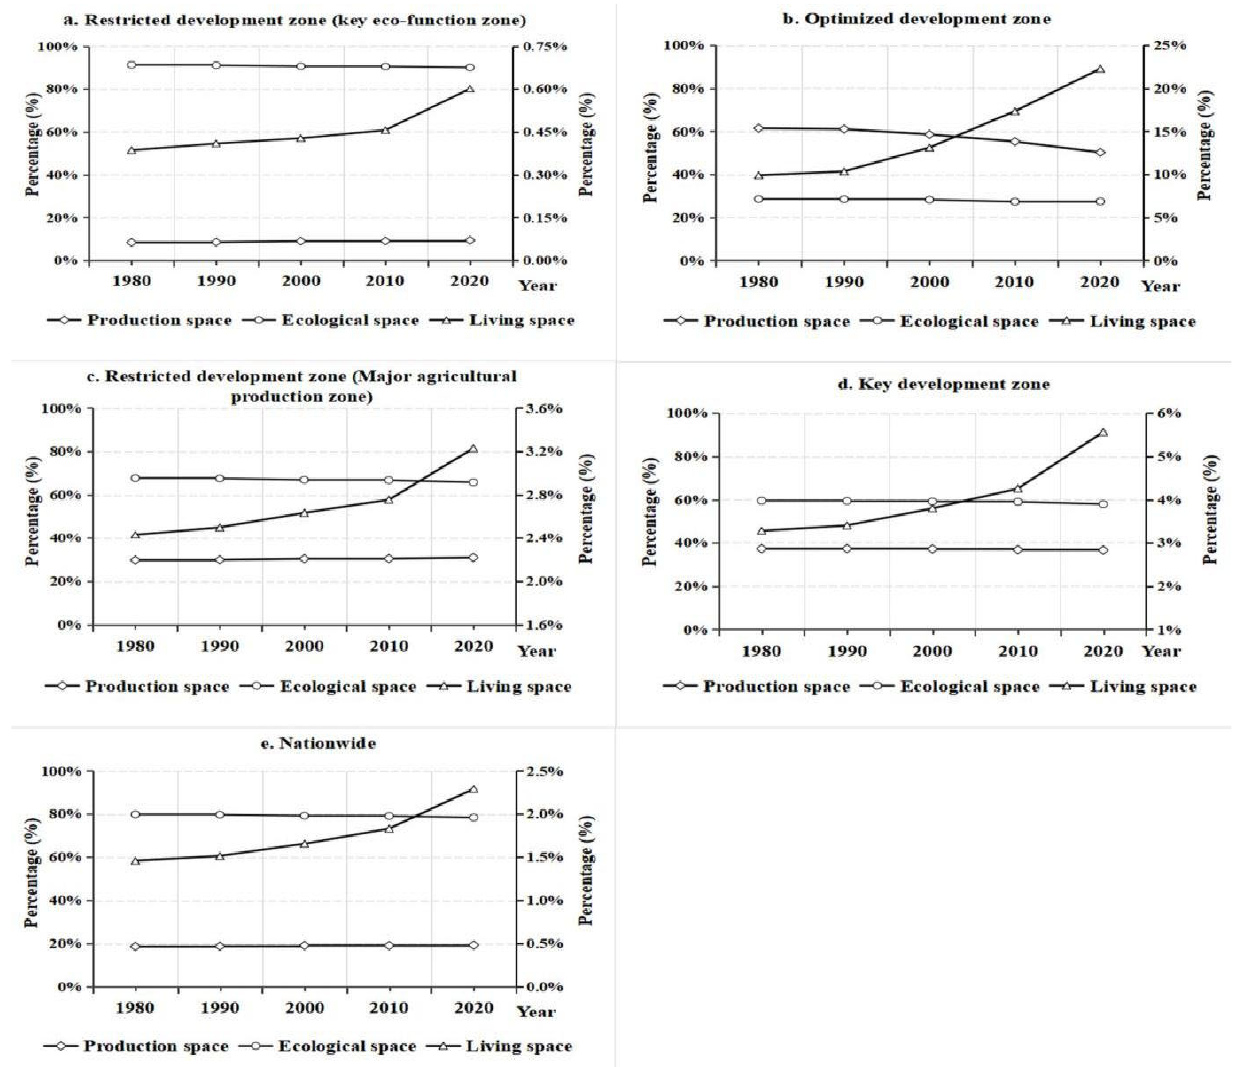
Figure 2. Proportion of PLES in major functional zones in China (%). Note: Production space and ecological space correspond to the main axis ( left ); living space corresponds to the sub ‐ axis ( right ).